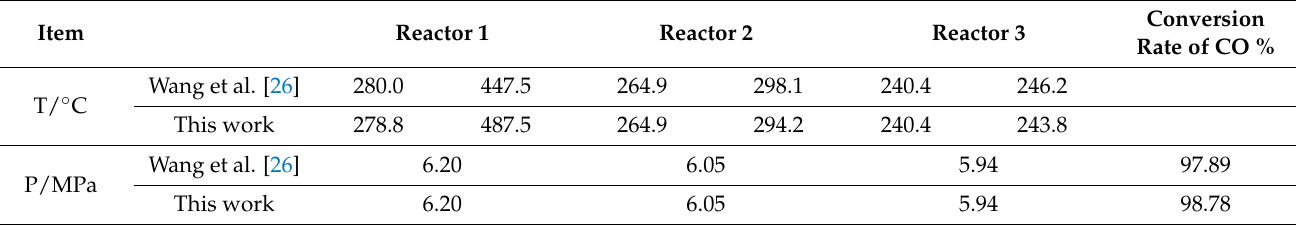
Table A4. Validation of water gas